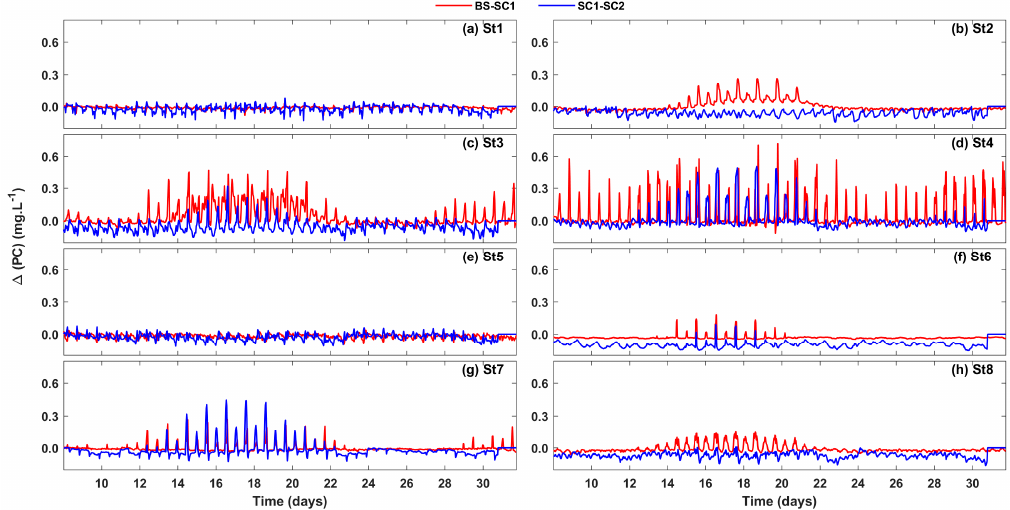
Figure 16. Time series of carbon phytoplankton concentration di ff erence, ∆ (PC), between the scenarios (BS–SC1 and SC1–SC2), for September 2000 and the lagoon stations: ( a ) St1, ( b ) St2, ( c ) St3, ( d ) St4, ( e ) St5, ( f ) St6, ( g ) St7 and ( h )